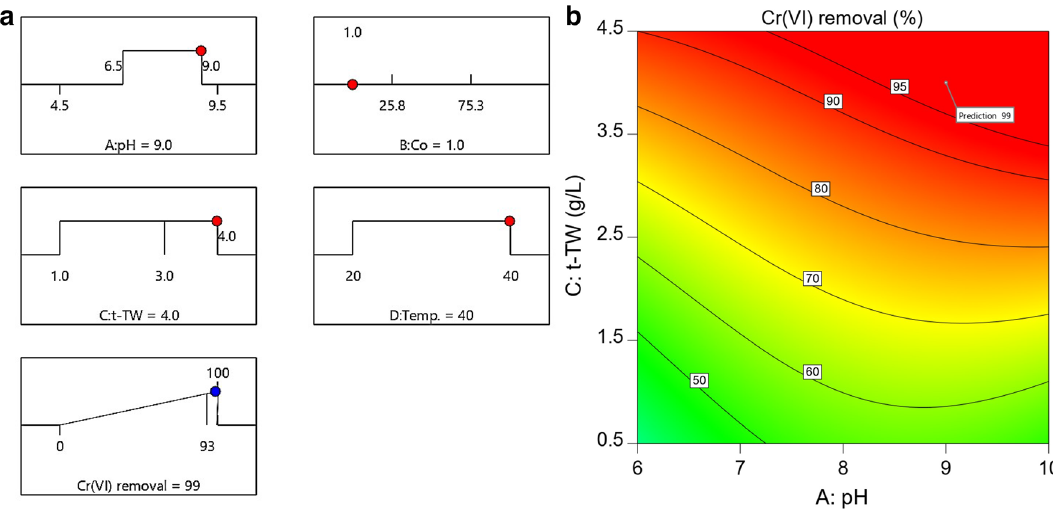
Figure 6. ( a ) Ramp plots and ( b ) a contour plot representing optimized conditions for ≥ 99% removal of Cr(VI) from water. The flag indicates the location of parameters for optimized removal. (Contact time: 48 h; initial